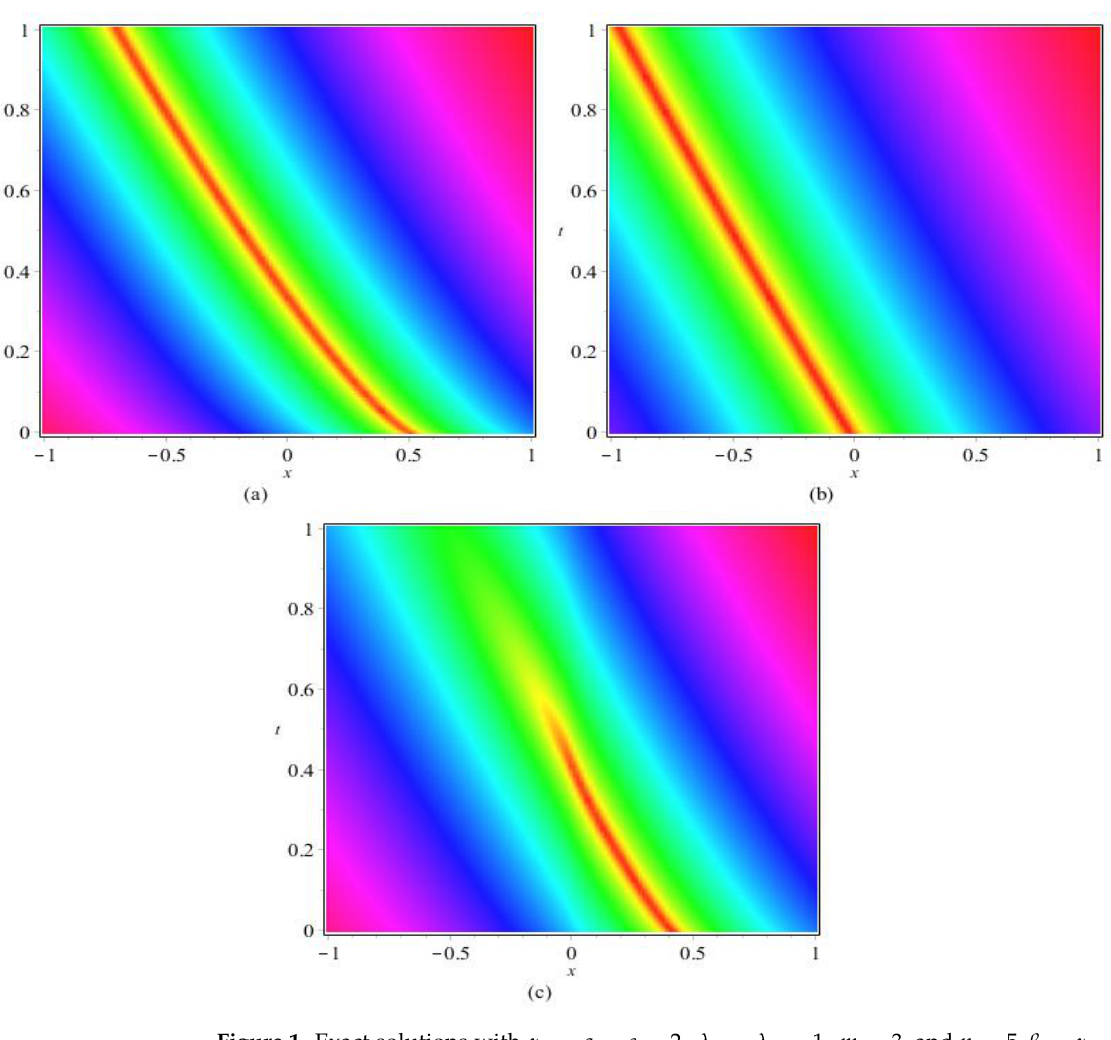
Figure 1. Exact solutions with α 1 = a = c = 2, λ 2 = λ 3 = 1, m = 3, and n = 5, β = α = 0.9 w.r.t. ( a ) M-derivative (15), ( b ) beta-derivative (16), ( c ) hyperbolic-derivative